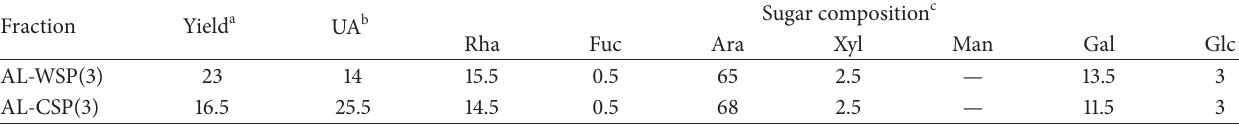
Table 3: Monosaccharide composition of water-soluble AL-WSP(3) and chelating-soluble AL-CSP(3) pectins. Fraction Yield a